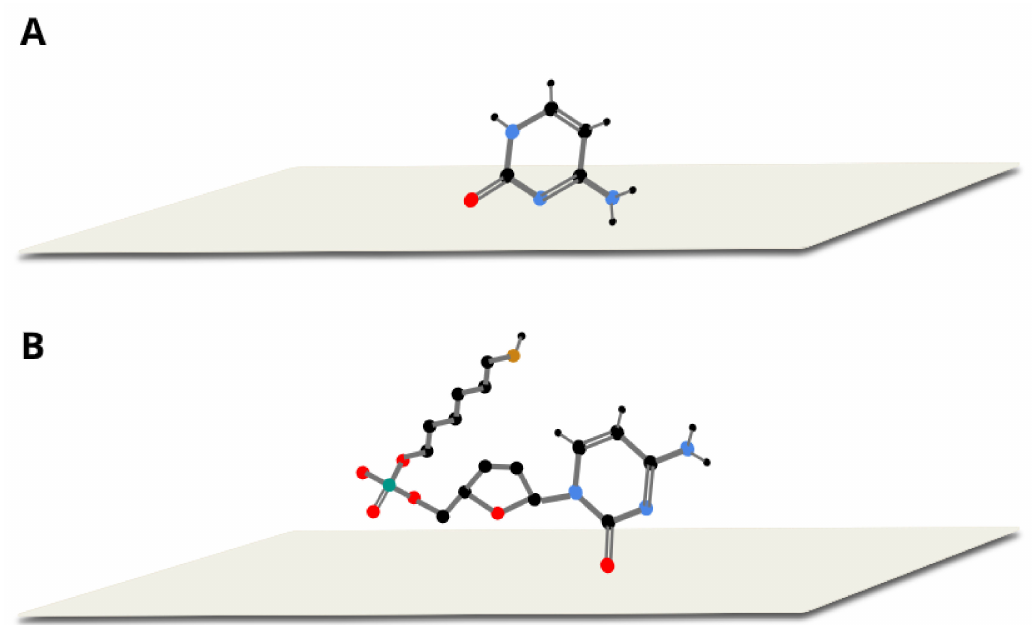
Figure 7. Proposed orientation of cytosine ( A ) and thiolated cytosine mononucleotide ( B ) on gold colloidal